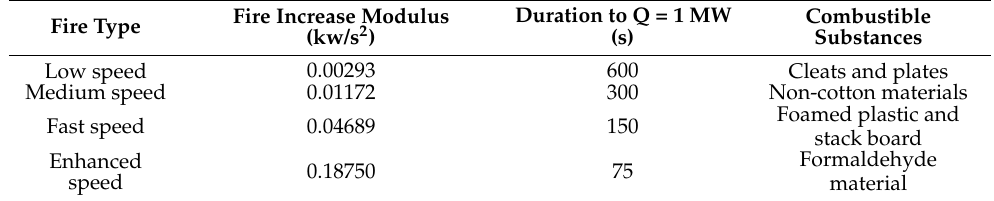
Table 4. Characteristics of four fire growth models according to the t 2 fire